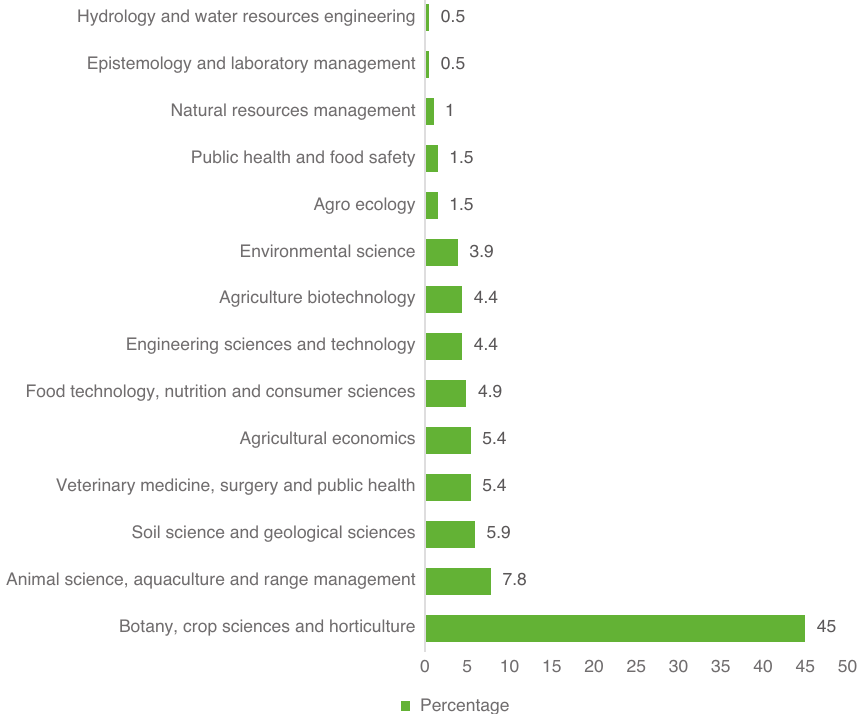
Fig. 5: Researchers’ Academic Field of Specialization (n =